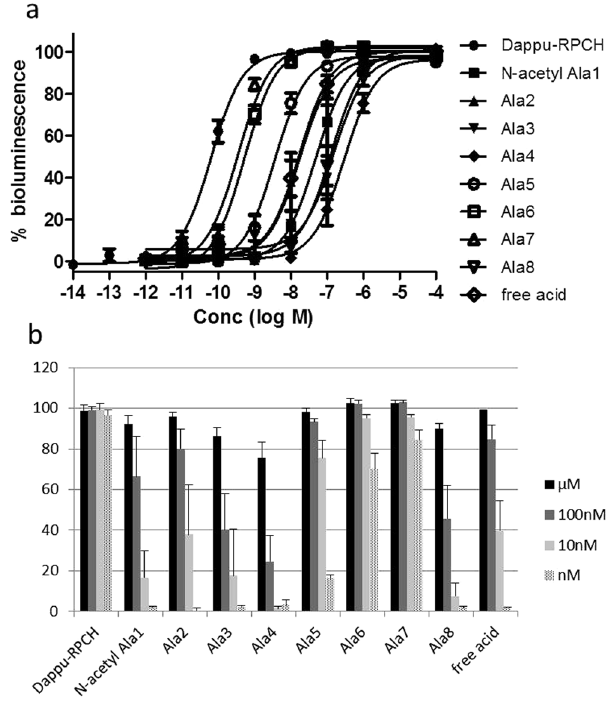
Figure 6. Structure-activity relationship of Dappu-RPCH and analogues thereof tested on Dappu-RPCHR expressing cells in an in vitro bioluminescent assay. ( a ) Full structure-activity curves; data shown as Mean ± SD, each experiment was performed in triplicate, and % bioluminescence is a proxy for receptor activation. ( b ) Receptor activation data shown as a histogram in the micro- to nanomolar range for each Dappu-RPCH analogue. Table 2 shows peptide structure and EC 50